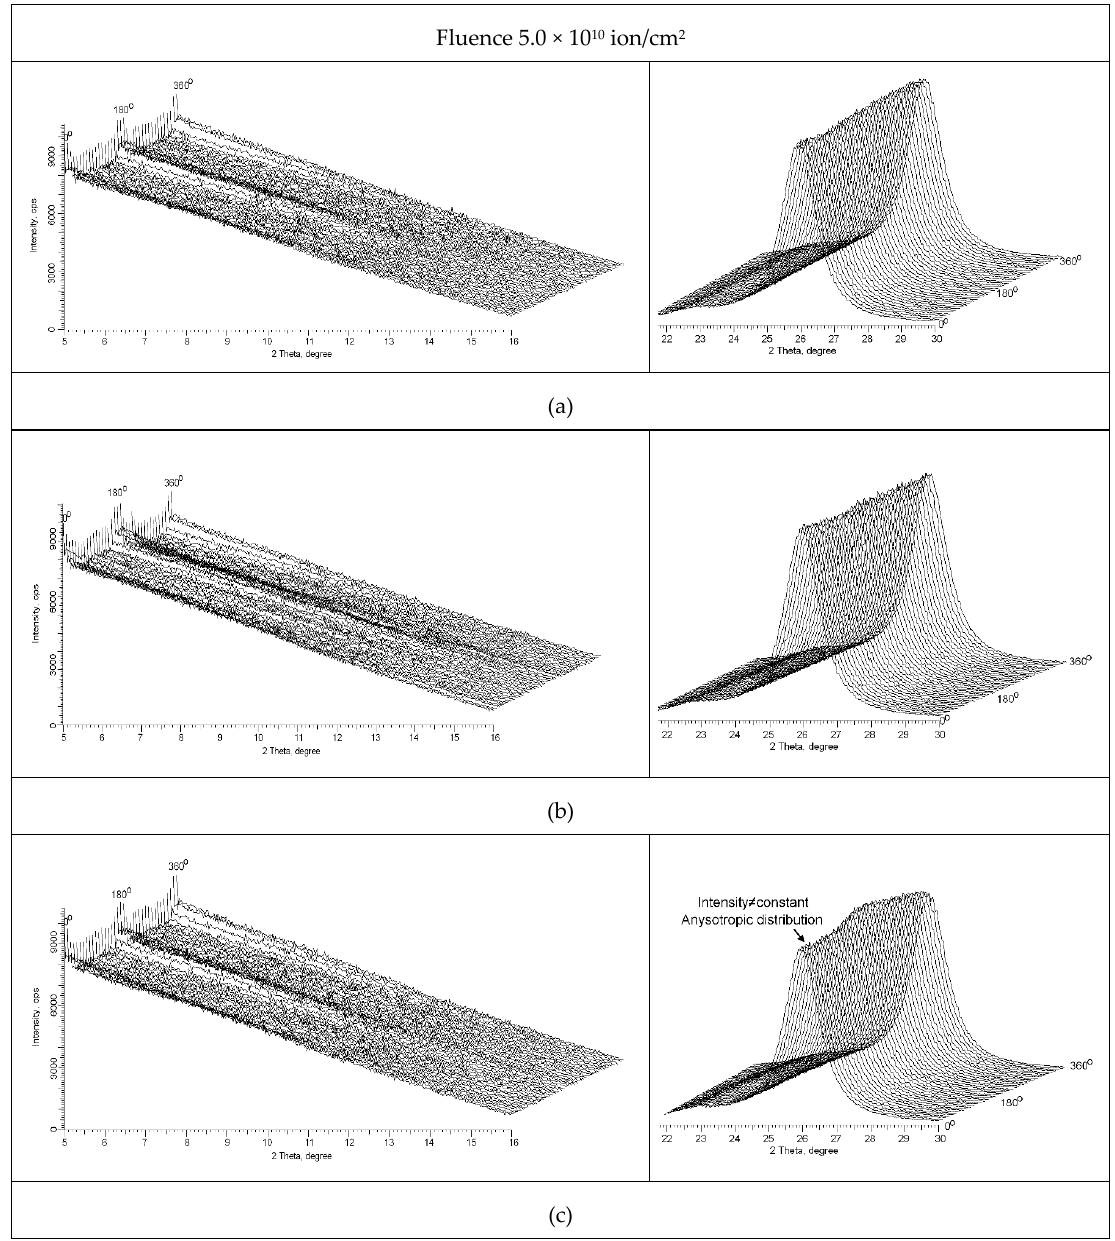
Figure 2. X-ray diffraction patterns of test samples polymer films: ( a ) irradiated Kr 13+ ions; ( b ) Figure 2. X-ray di ff raction patterns of test samples polymer films: ( a ) irradiated Kr 13 + ions; ( b ) irradiated irradiated Kr 14+ ions; ( c ) irradiated Kr 15+ ions for a fluence of 5 × 10 10 ions/cm 2 . Kr 14 + ions; ( c ) irradiated Kr 15 + ions for a fluence of 5 × 10 10 ions / cm 2 . Figure 2: Fluence of 5 × 10 10 ions/cm 2 Figures 4 and 5: Fluences of 7.5 × 10 10 ions / cm 2 and 1 × 10 11 ions / cm 2 The X-ray diffraction pattern for the lowest initial ion charge (Kr 13+ ) (Figure 2a, red lines Figure 3a below) exhibits the same qualitative features as those seen for Ar 8+ ions at the lower two fluences used in [22]: a meridian reflection in the region 2 θ = 5–12° showing induced ordering in the amorphous phase and an azimuthally isotropic diffraction ring at 2 θ = 26° in the crystalline phase,